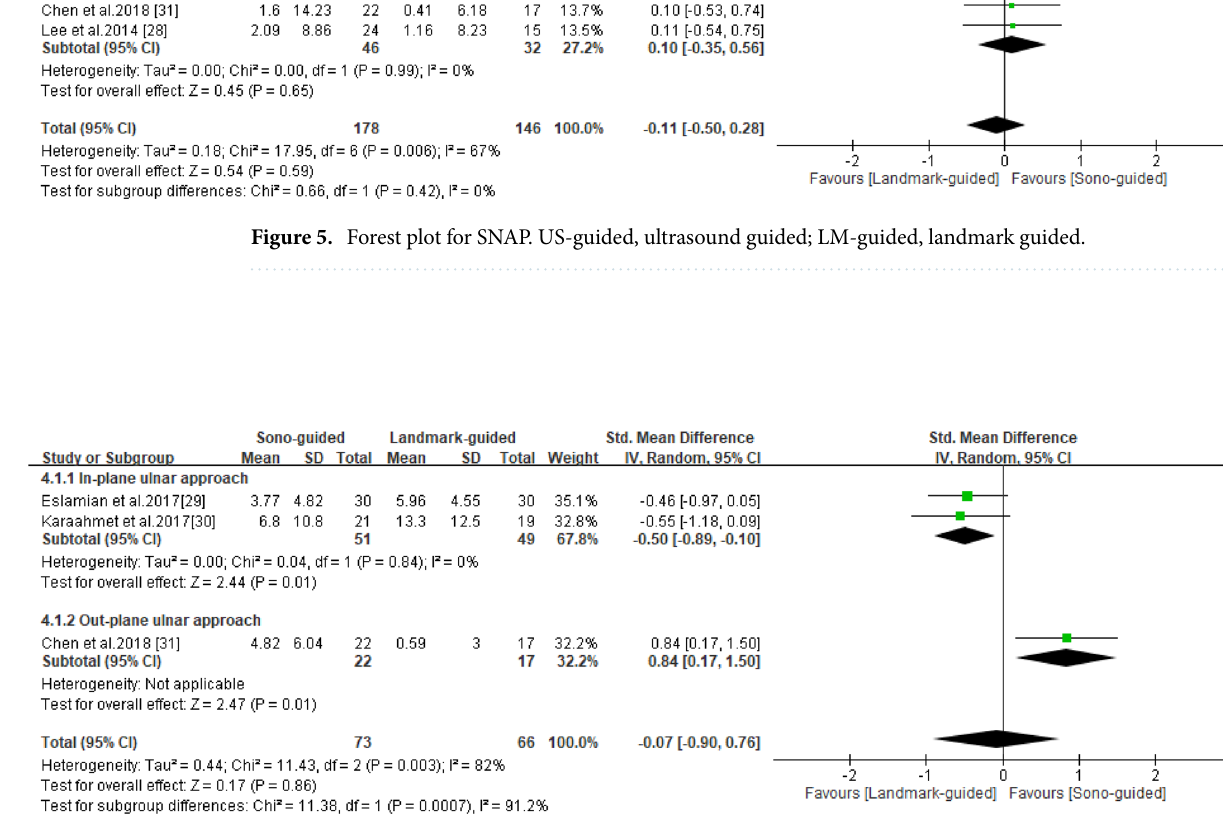
Figure 6. Forest plot for SNCV. US-guided, ultrasound guided; LM-guided, landmark